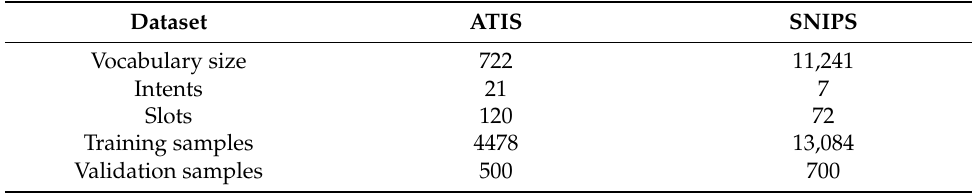
Table 2. Specific statistics of the two